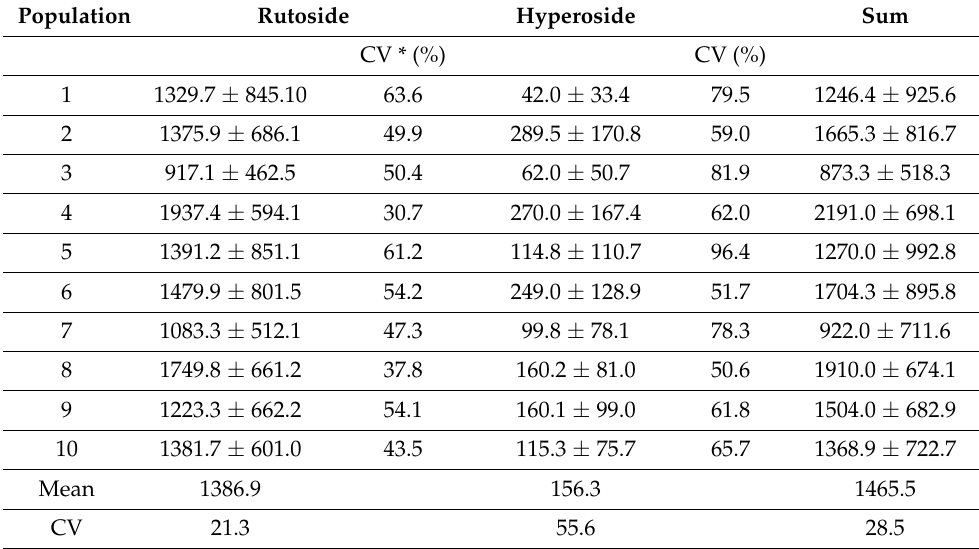
Table 2. The content of detected flavonoids (mg/100 g DW). Population